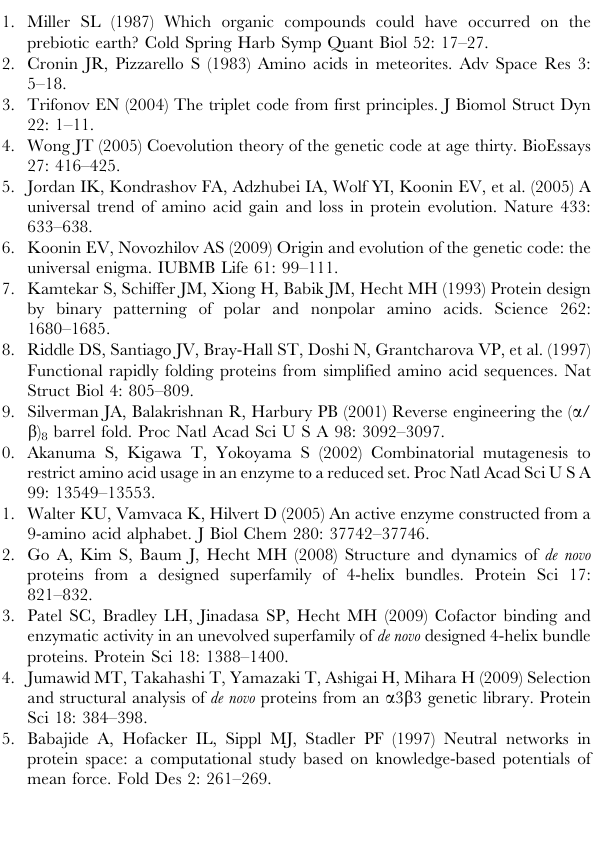
Table S3 Percentage of each nucleotide at each position of the designed